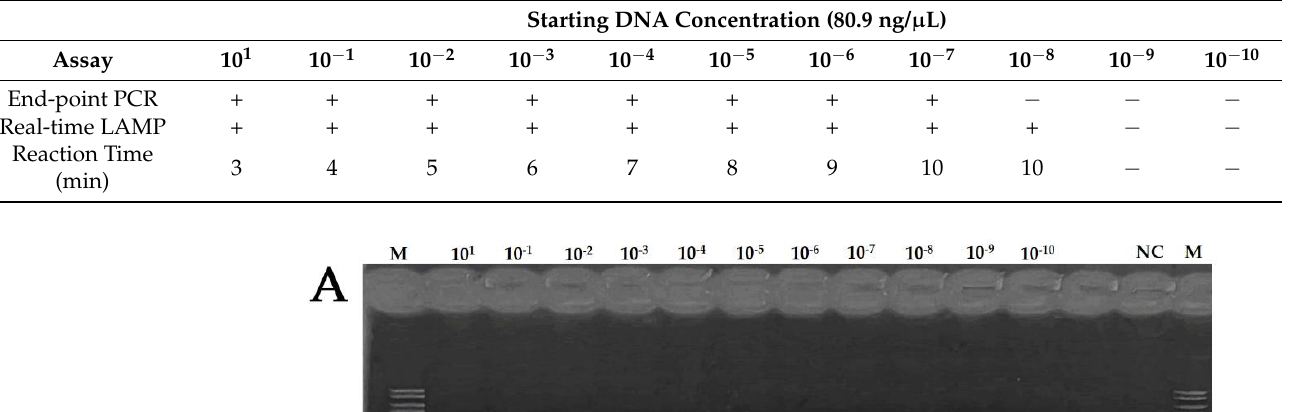
of real-time LAMP assay; ( B ): Melting curves of the amplification curves previously obtained,